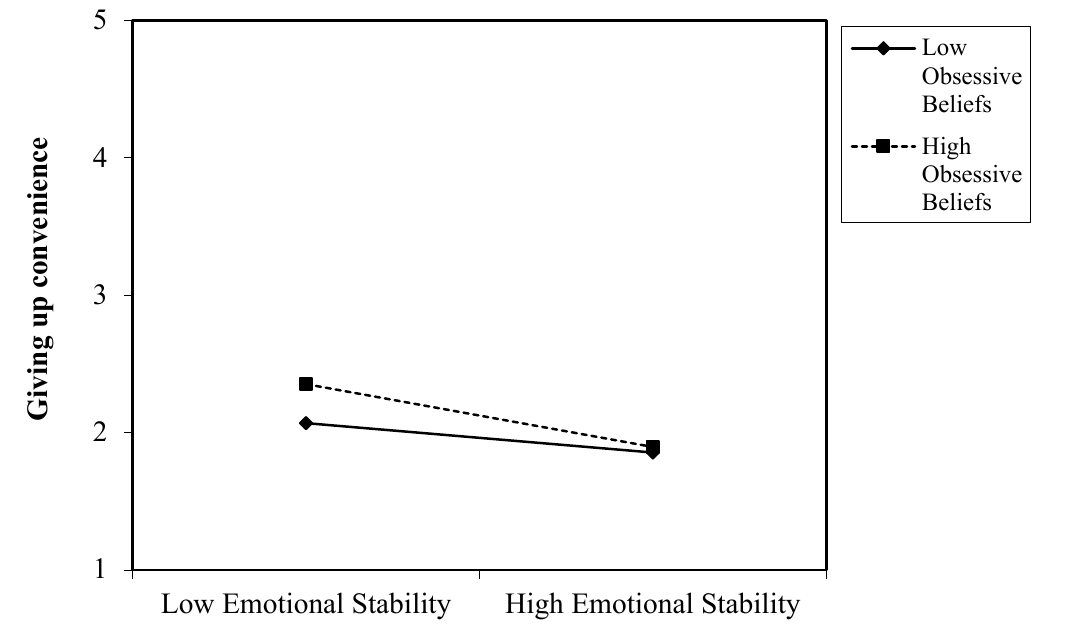
Figure 2. Interaction of emotional stability and obsessive beliefs in predicting the fear of giving up convenience.